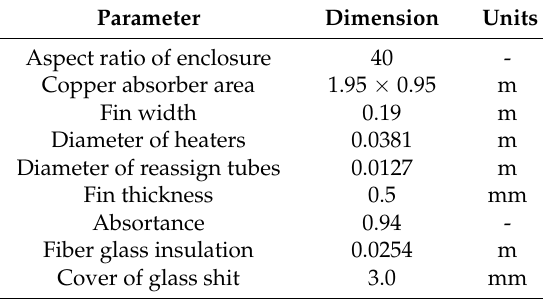
Table 1. Construction specifications of the solar